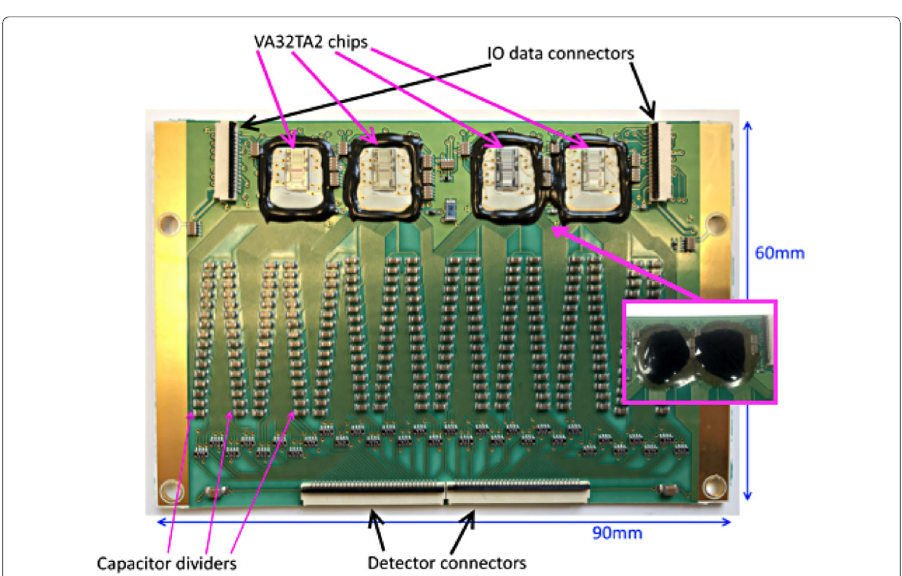
Fig. 15 Front-end PCB with VATA chips; in the inset, the epoxy protection layer is